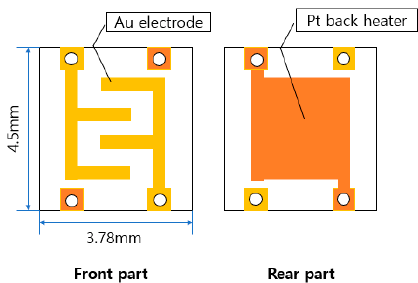
Figure 1. Schematic diagram of the entire sensor board.